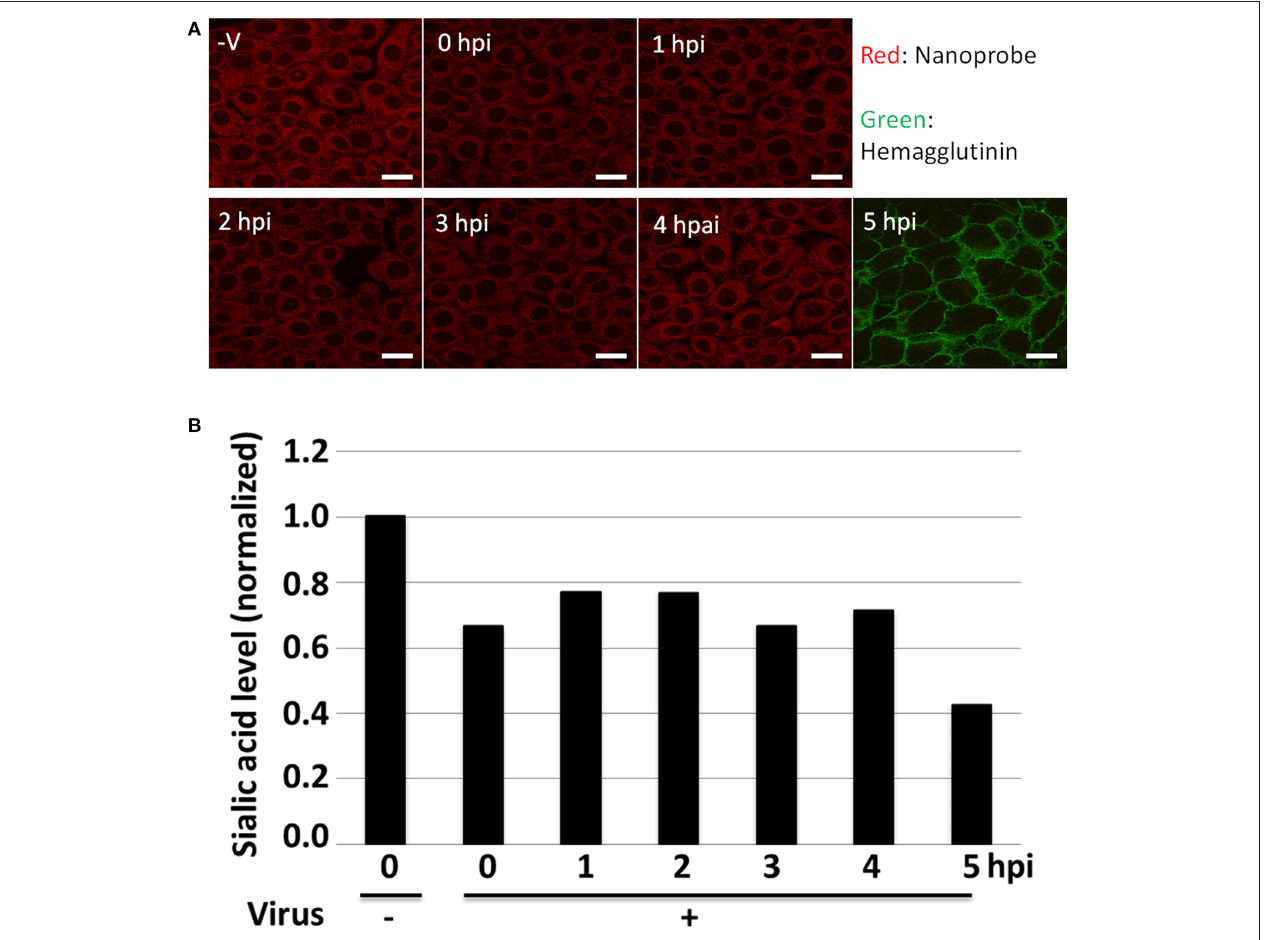
FIGURE 3 | The detection of membrane-bound α -2,6-sialic acids visualized using the nanoprobes. (A) The fluorescence images of virus-infected H292 cells reacted with SNA-conjugated fluorescent polymeric nanoparticles [Red; viral infection time from 0 to 5 h post-infection (hpi)]. Controls without viral infection (–V) and the presence of HA (Green) after the viral infection are also shown. Scale Bar: 20 µ m. (B) The normalized fluorescence intensities of virus-infected H292 cells reacted with SNA-conjugated fluorescent polymeric nanoparticles [viral infection time from 0 to 5 h post-infection (hpi)]. Result for the control without viral infection (–) is also shown and the data set was normalized to the